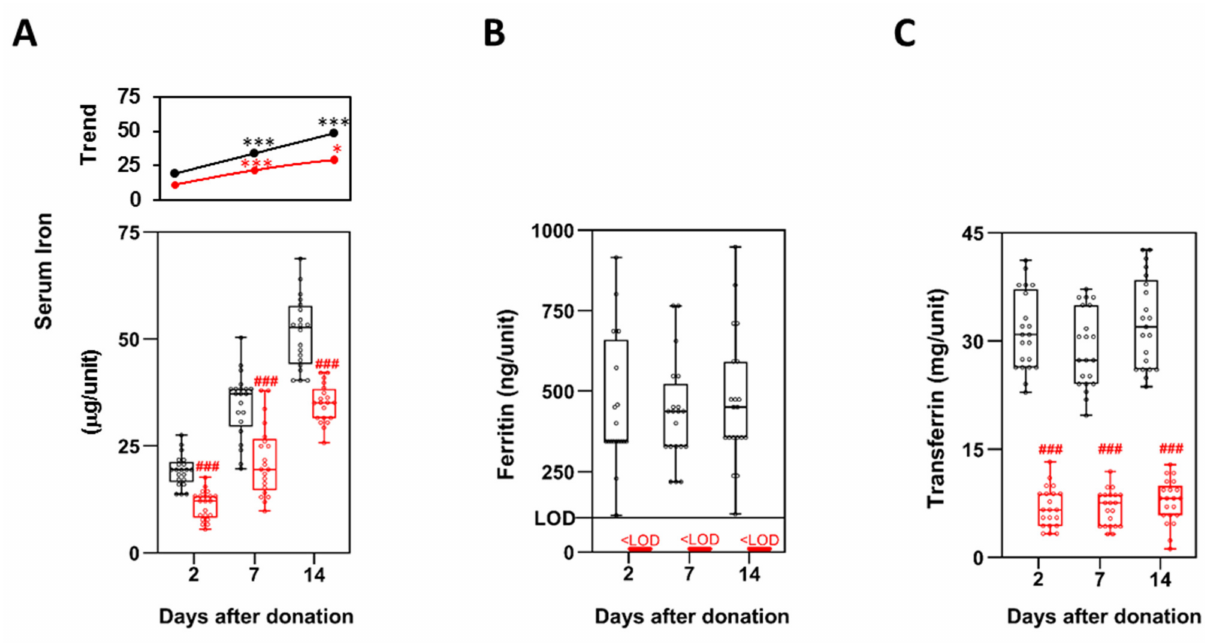
Figure 4. Iron metabolism in the two methods at 2, 7 and 14 days after storage, expressed as concentration/unit. In serum iron ( A ), points and lines in the top panels of ( A ) indicate differences between consecutive time points, as described in Figure 2; In the Ferritin ( B ) and Transferrin ( C ) panels, the horizontal line indicates the limit of detection: values measured in method 2 samples were all below this limit (1 ng/mL according to manufacturer’s, which here is normalized for the maximum unit volume measured, 180 mL). Method 1 is in black, method 2 in red. The boxplots were prepared as described in Figure 2. Red # indicate significant differences between the two methods at the various time points. ### p < 0.001. * p < 0.05, *** p <